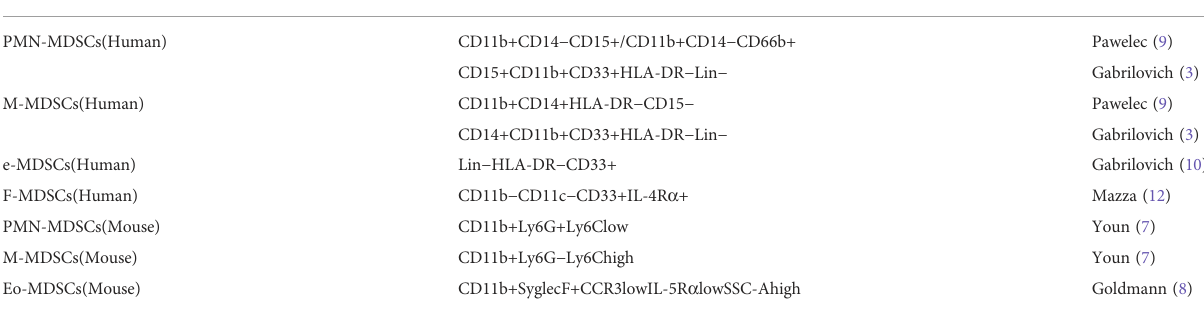
TABLE 1 Phenotypes of